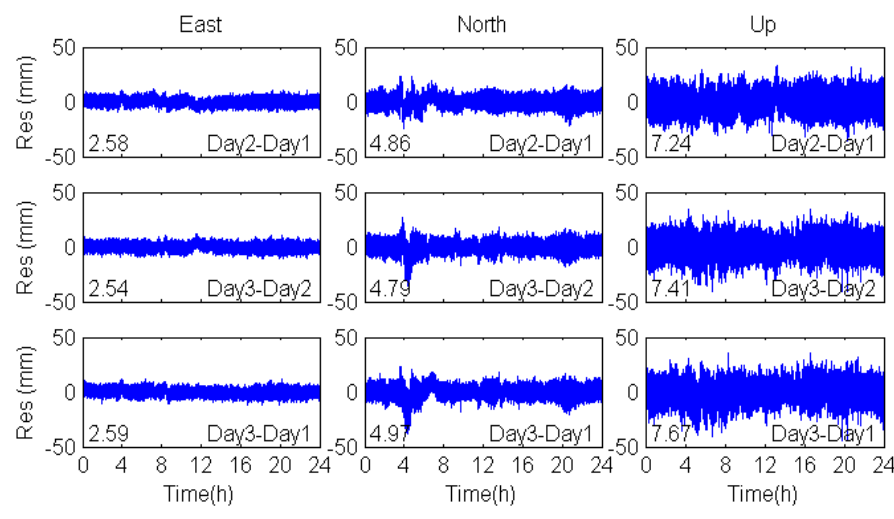
Figure 8. Sidereal filtering results in the coordinate domain for multipath errors in the east, north and vertical coordinate directions.